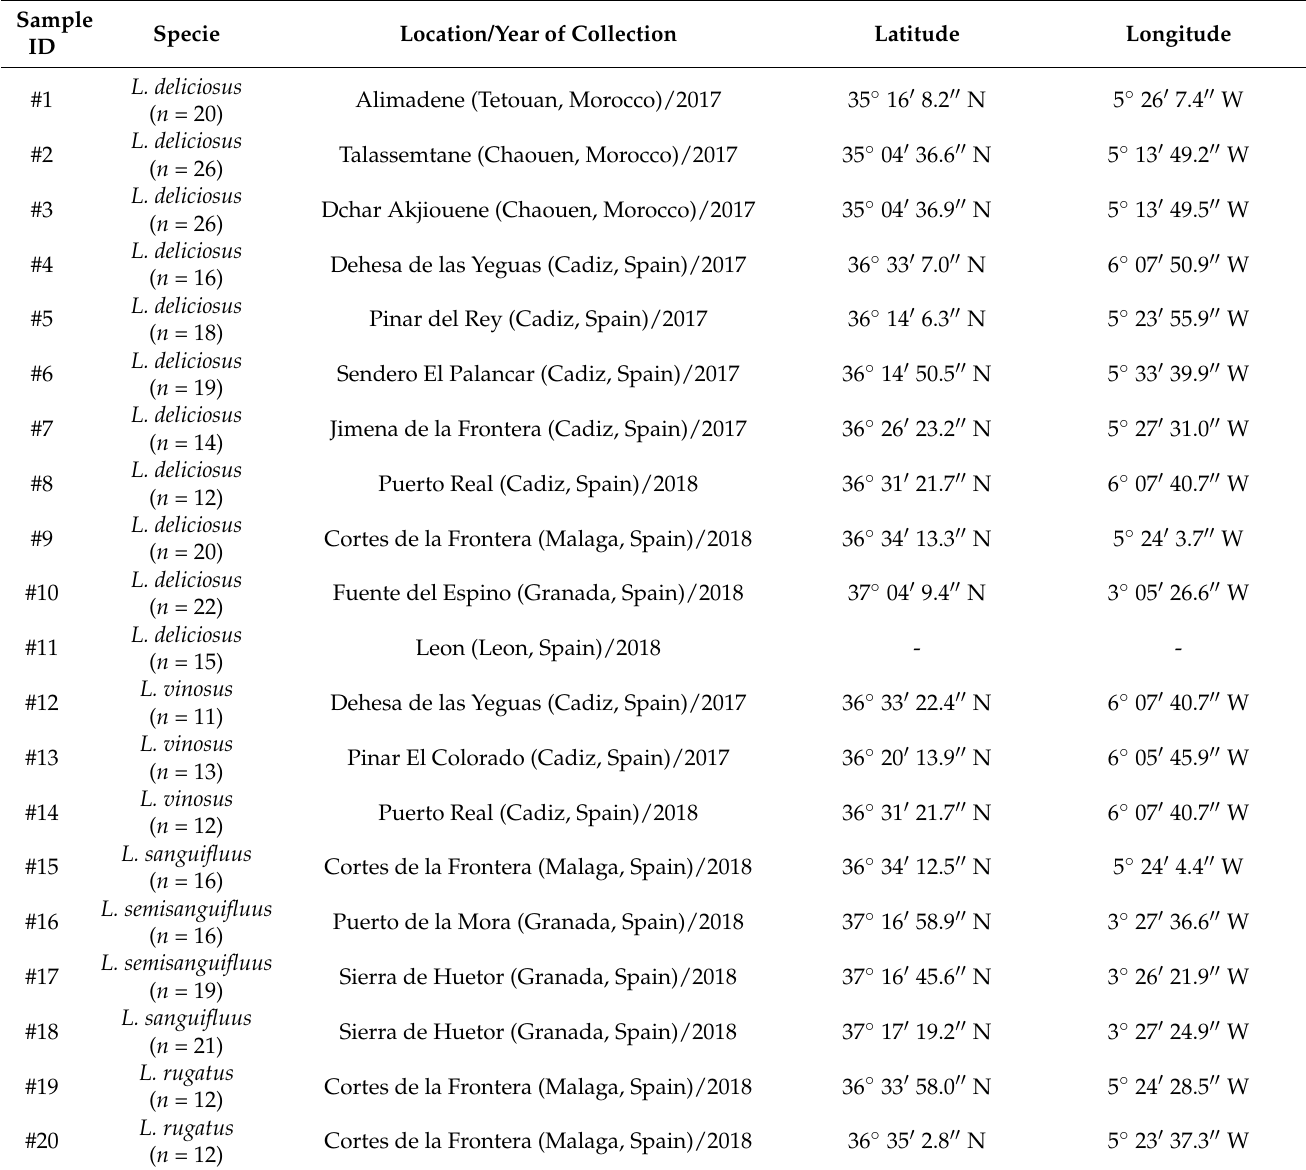
Table 1. List of all samples of Lactarius mushrooms analyzed with their corresponding sample ID, specie, specimen number ( n ), collection location, sampling year, and geographical